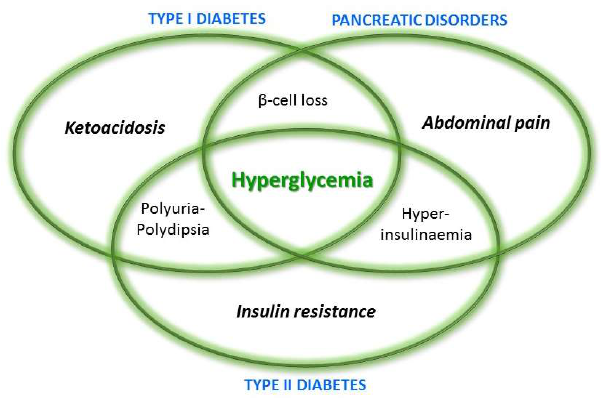
Figure 2. Schematic overview of shared aspects of type I–II diabetes and pancreatic